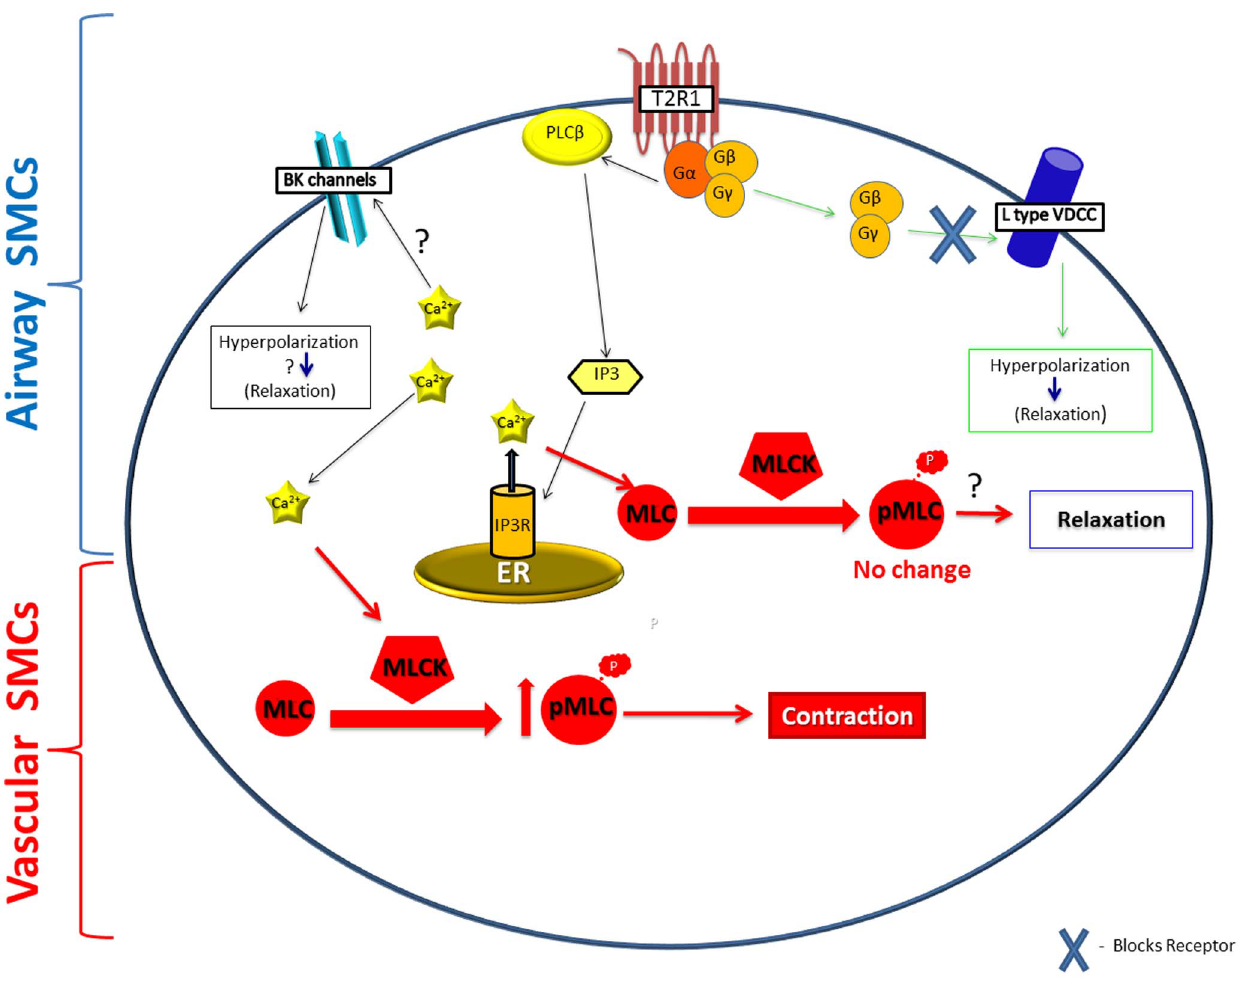
Figure 7. Schematic representation of the contrasting effects of DXM-induced vasoconstriction in PASMCs and relaxation in ASMCs. In our model we propose that in PASMCs DXM activates the canonical T2R signaling cascade to cause significant increase in IP 3 production resulting in increase in global [Ca 2 + ] i levels. The increased [Ca 2 + ] i subsequently leads to activation of myosin light chain kinase (MLCK) thus resulting in an increase in the phosphorylated form of MLC (pMLC). Increase in pMLC ultimately leads to the constrictor effects observed in the pulmonary arterial rings. The molecular mechanism(s) underlying T2R mediated relaxation of the airways was studied by different groups. Deshpande DA, et al , [7] showed that T2R activation results in localized [Ca 2 + ] i mobilization which opens up large-conductance Ca 2 + activated K + (BK ca ) channels leading to ASM membrane hyperpolarization and relaxation. Recently, Zhang C, et al , [26] demonstrated that activation of T2Rs in airways (resting state) leads to increase in global [Ca 2 + ] i levels, however, these are not sufficient to impact airway contractility. In a second pathway, they proposed bitter tastants inhibit L-type voltage-dependent Ca 2 + channels (VDCCs) via a G-protein bc dependent process, to induce bronchodilation of pre-contracted ASM. of T2R1 in human and porcine PASMCs and ASMCs, we tested the ex vivo effect of DXM on porcine pulmonary arterial and airway rings. We found that DXM treatment of the pulmonary arterial rings caused vasoconstriction with an EC 50 of 211 6 2 m M ( Figure 5B ). The effect of DXM on U46619-precontracted arterial rings was also analyzed in this study. DXM, starting from 100 m M, caused contraction of precontracted rings (Figure S4 in File S1). This might be a synergistic effect of DXM and U46619 on the pulmonary artery. The role of endothelium was also analyzed in this DXM-mediated response of pulmonary arterial rings. DXM-treatment of endothelium-denuded pulmonary arte- rial rings did not show much change in EC 50 value of DXM (238 6 1 m M, Figure S5 in File S1). Study by Manson et al . showed that bitter agonists, chloroquine, DXM, and noscapine lead to relaxation of precontracted human pulmonary arteries [25].